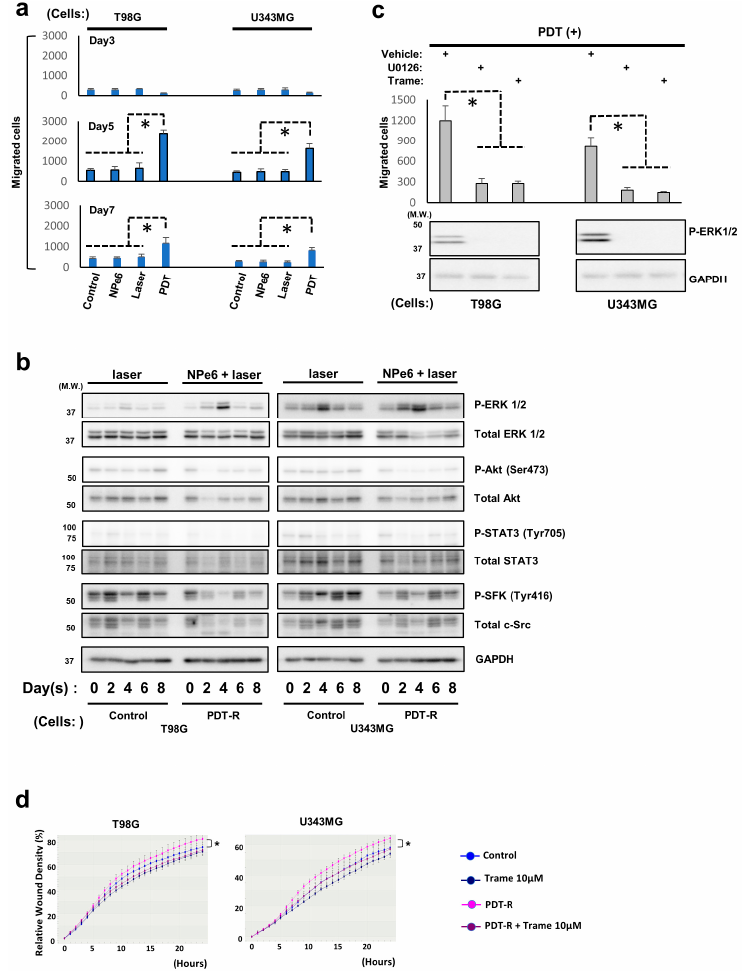
Figure 4. Enhanced migration of NPe6-PDT-R cells is regulated by enhanced ERK1 / 2 activation. ( A ) Control and NPe6-PDT-R T98G and U343MG cells were photographed under a phase-contrast microscope ( × 400). Scale bar, 10 µ m. ( a ) T98G and U343MG cells were subjected to vehicle treatment (control), NPe6 treatment (15 µ g · mL − 1 ), laser treatment, or NPe6-PDT (NPe6, 15 µ g · mL − 1 ), as